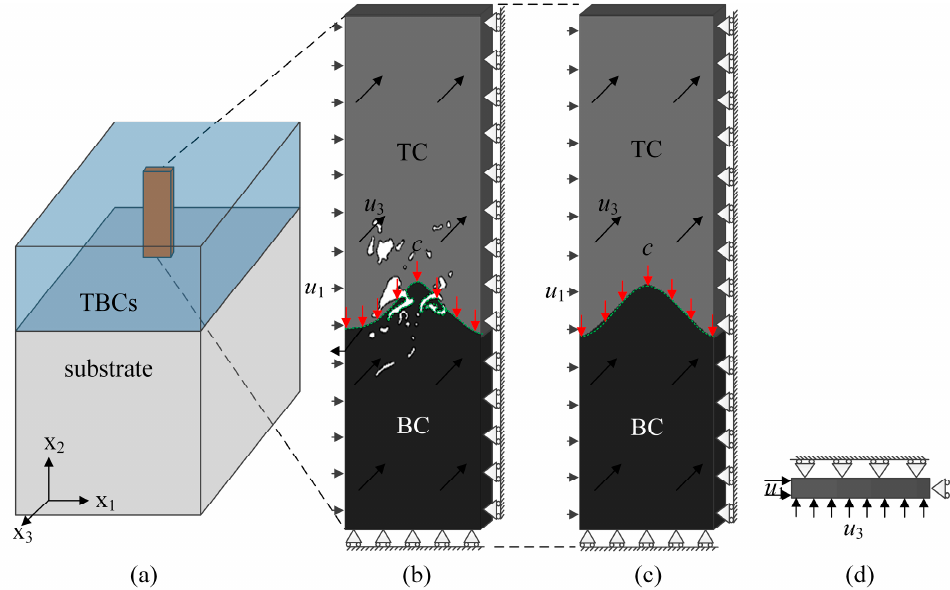
Figure 2. ( a ) Schematization of TBC; Boundary conditions for the simulated domain of TBC with ( b ) cosine-interface and ( c ) actual microstructures; and ( d ) Top view image of the simulated domain.